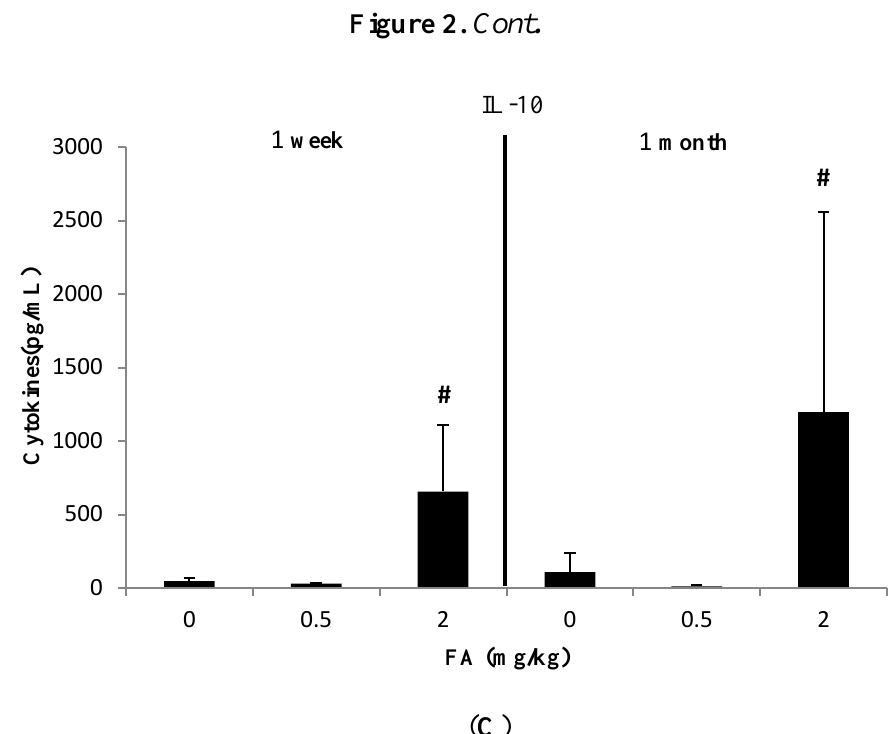
Figure 3. Effect of FA on IL-17A (Th17-related cytokine) in serum of C57BL/6 mice.